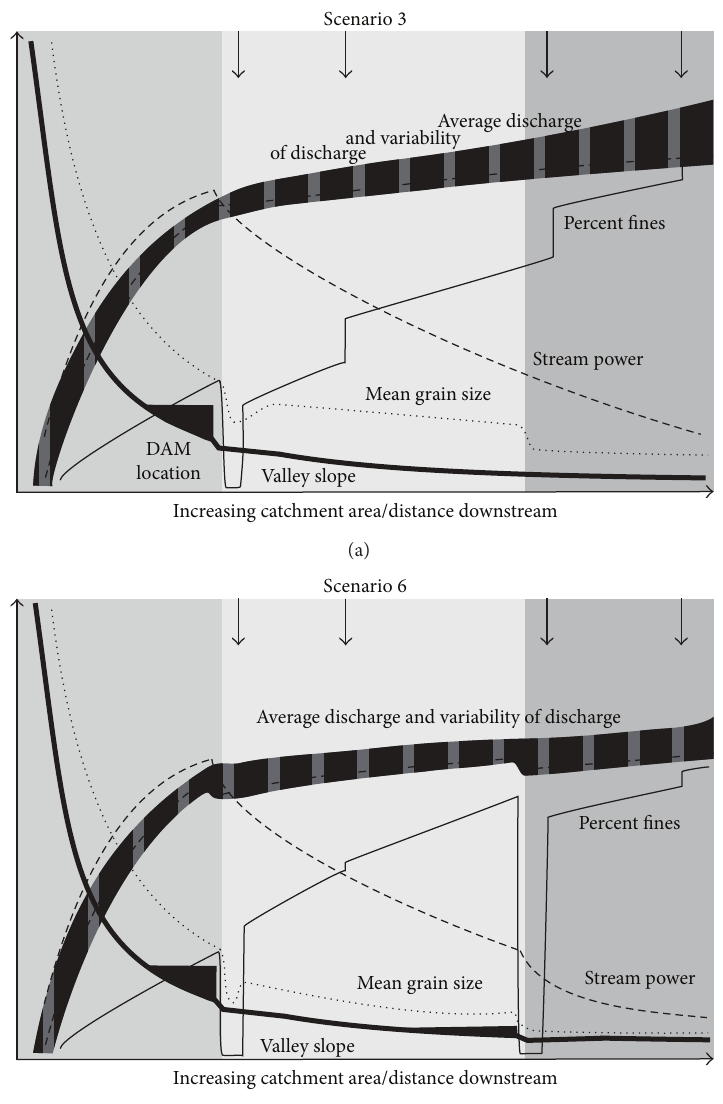
Figure6:Potentialimpactsofdamsonthedownstreamcontinuum,illustratedbymodifyingFigure 1.Thetwoscenariosmodelledcorrespond toScenario3andScenario6inTable 3.(a)Onedamintheupperthirdofthecatchment,withundammedtributariesandahydrologicalregime where bankfull flows are reduced in frequency, and all floods less than 1 in 20 years are eliminated. (b) Two dams; one located in the upper third, as in A, and a second dam on the floodplain. In this scenario, the dams modify the hydrological regime such that flows are held at near